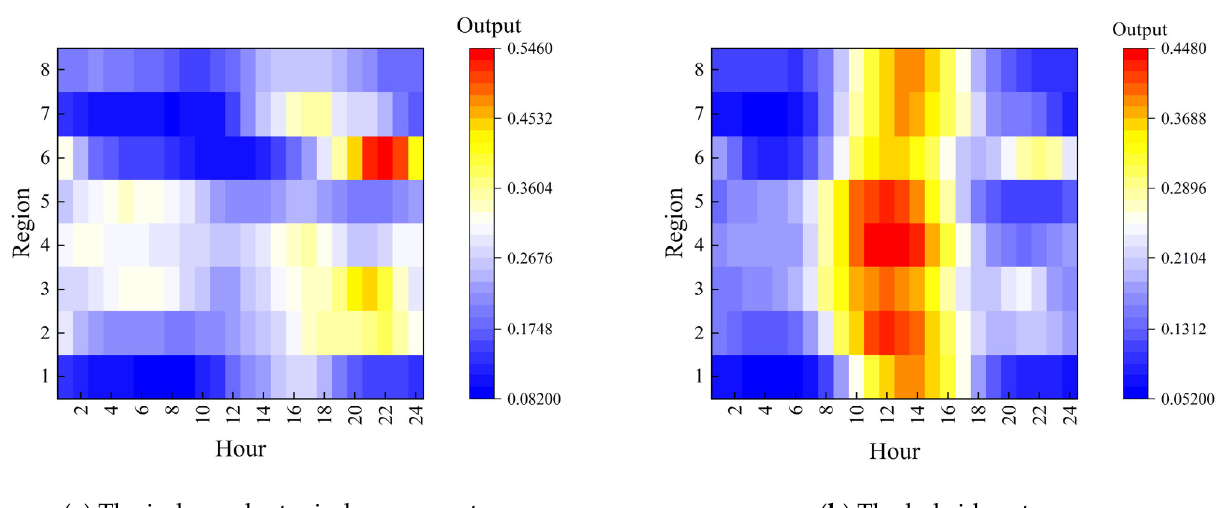
Figure 6. The independent output of the wind farm and the combined output of the hybrid system.